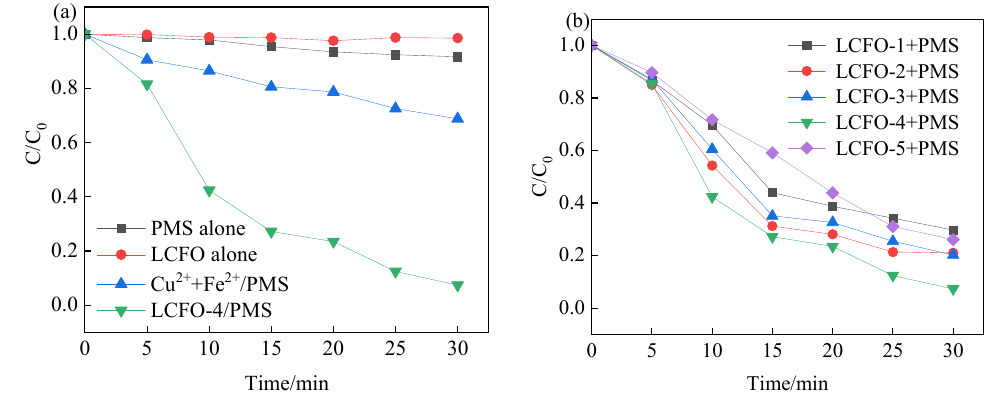
Figure 4. ( a ) The removal of BPA in different systems; ( b ) different Cu/Fe ratio contents. Conditions: C 0 = 0.05 mM, [Cu 2+ ] = 0.859 mg/L, [Fe 3+ ] = 0.048 mg/L, [LCFO] = 0.7 g/L, [PMS] = 10 mM, pH 0 6.8.